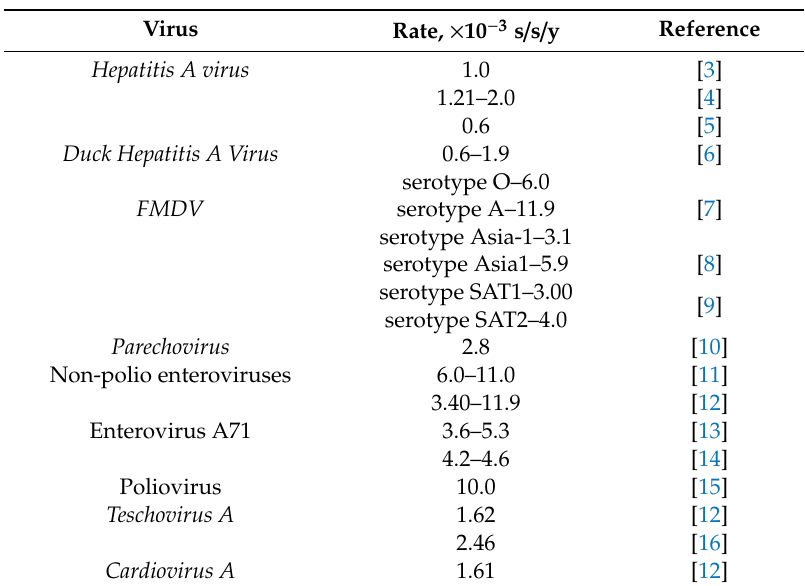
Table 1. Substitution rates in